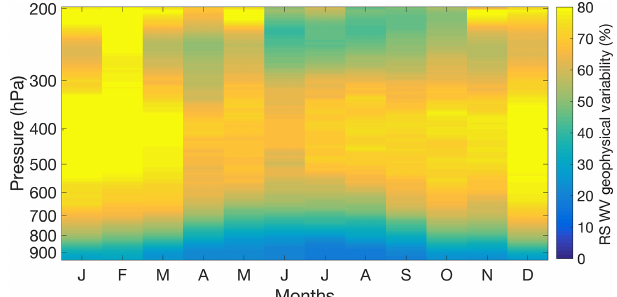
Figure 7. The water vapour geophysical variability estimated us- ing all available daytime and nighttime operational radiosondes as a percentage and function of pressure. The radiosondes see the same behaviour as the lidar, and the distribution of the variability is the same, although the magnitude is generally 20% larger. The larger magnitude is possibly due to the underestimation of the daily ra- diosonde